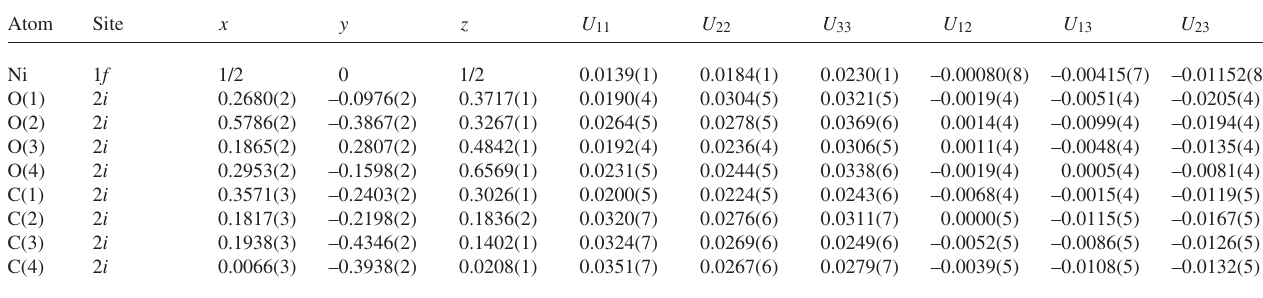
Table 3. Atomic coordinates and displacement parameters (in Å 2 )